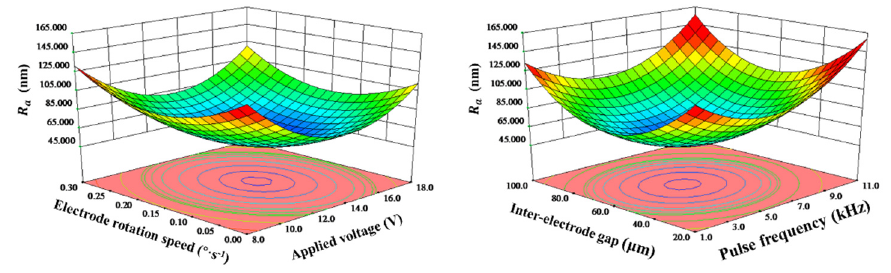
Figure 5. The interactions between process parameters on R a.